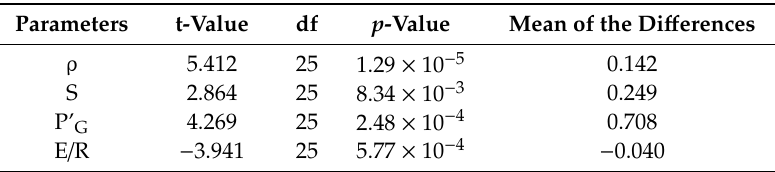
Table 3. Paired t-test summary statistics.